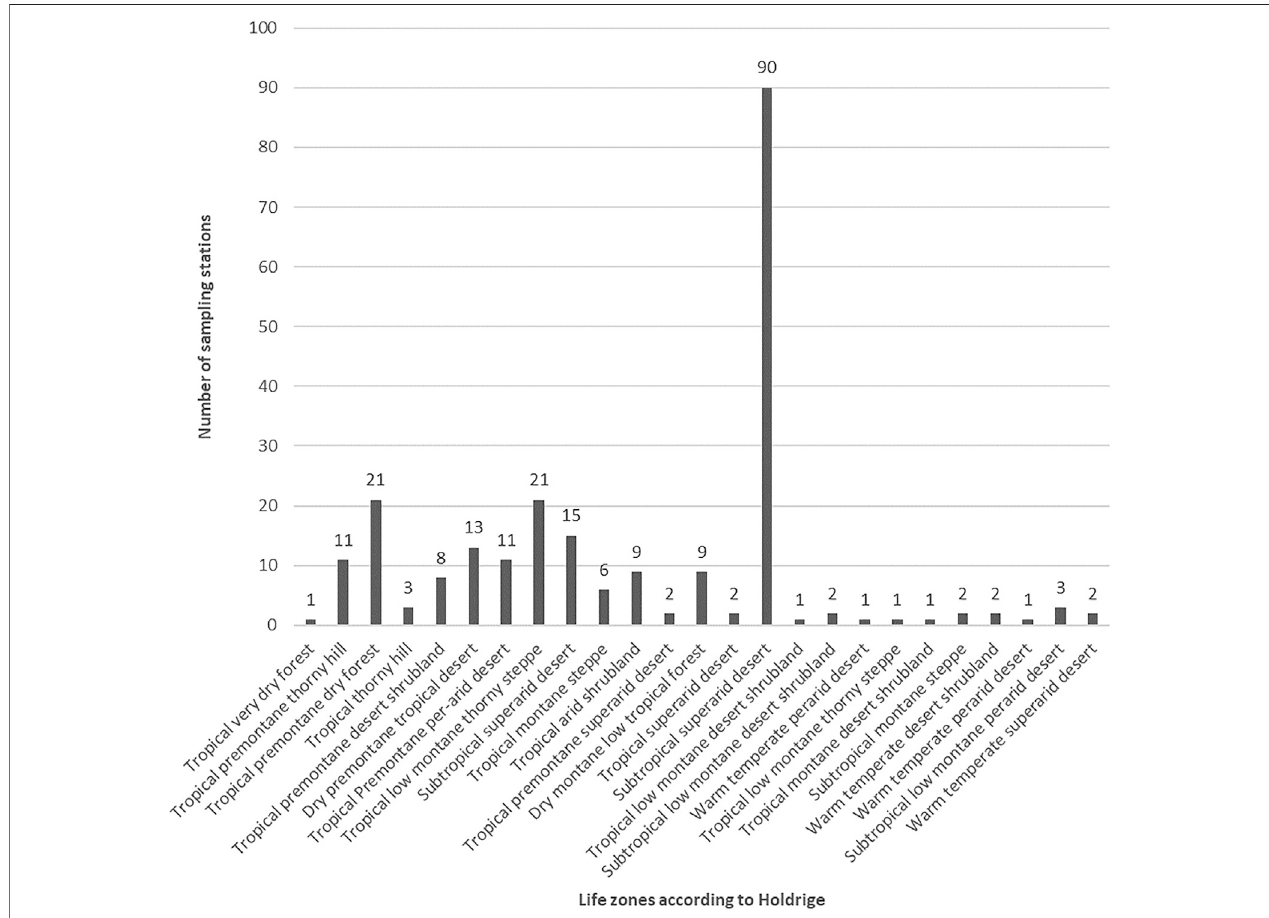
FIGURE 2 | Number of sampling stations by life zone studied between years 1992 – 2020.